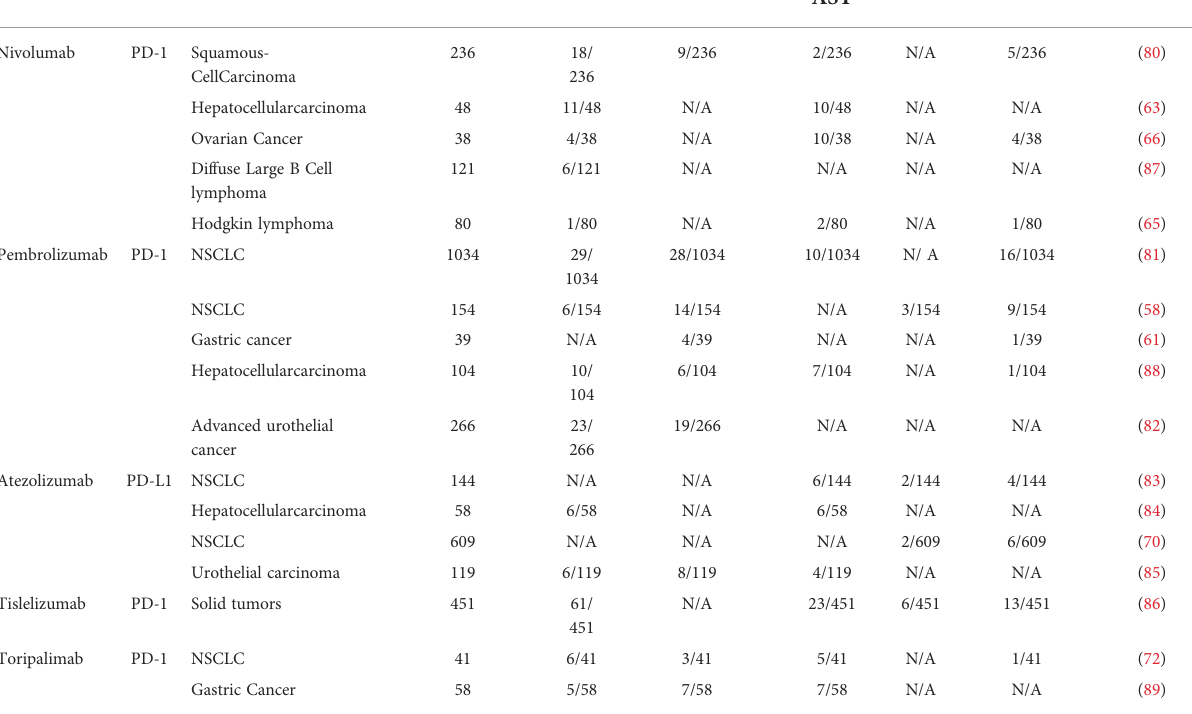
TABLE 2 Immune-related adverse events caused by PD-1/PD-L1 inhibitors in human cancers. Inhibitors